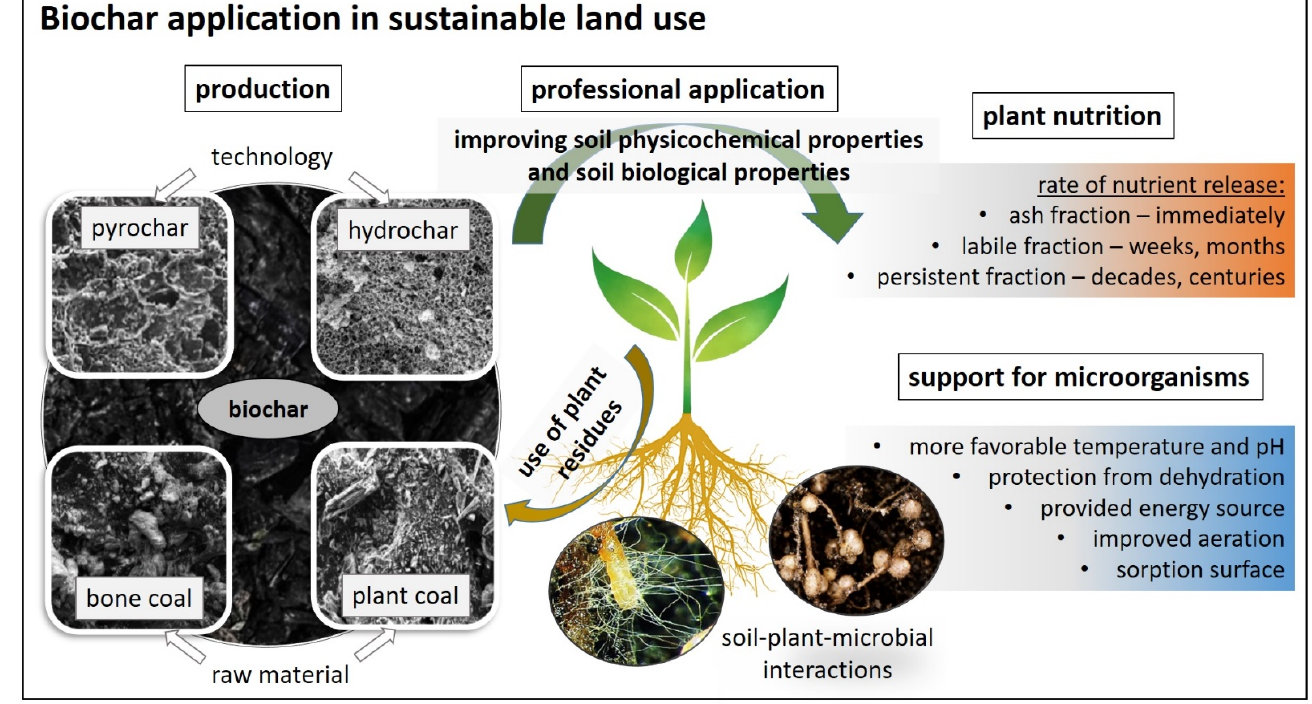
Figure 1. Main types of biochar and their agricultural uses.